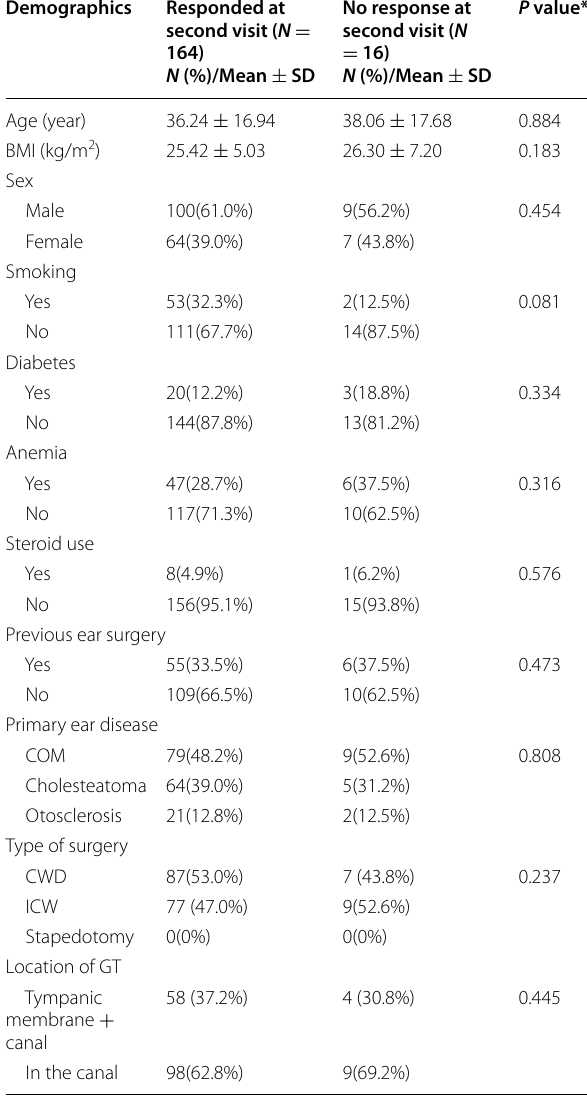
*Independent t test were used for age and BMI; chi-square test were used for the